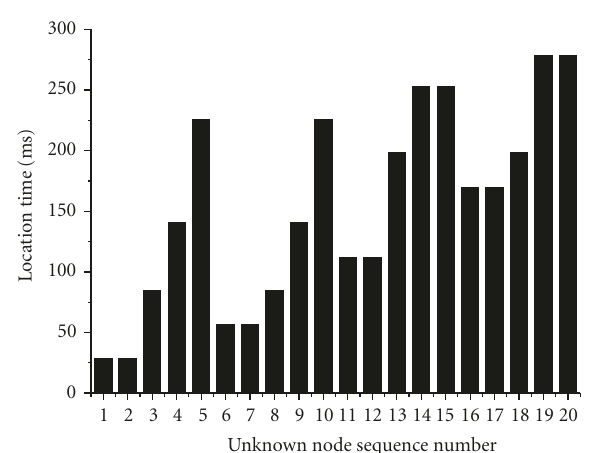
Figure 14: The location time of unknown node sequence number.